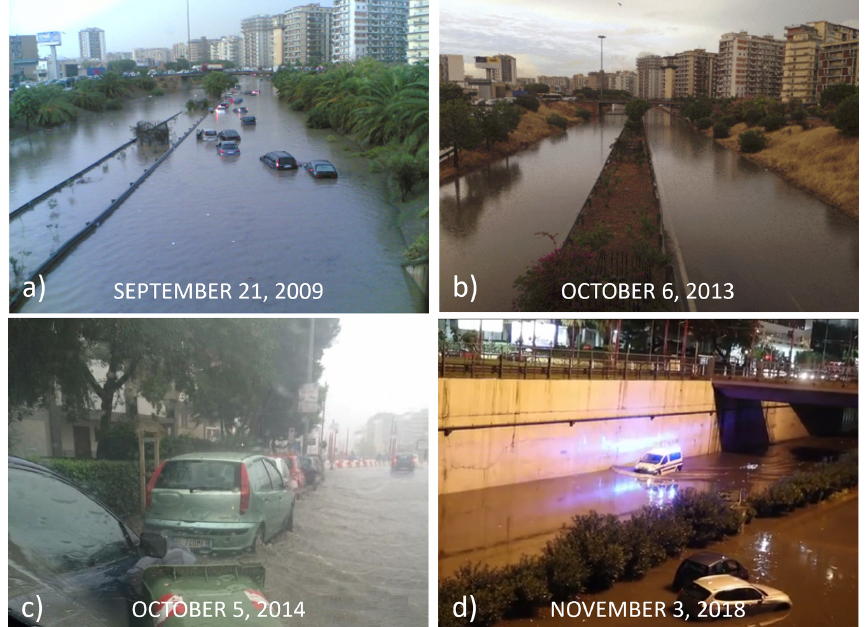
Figure 4. Flooding events that affected the Uditore–Passo di Rigano district on (a) 21 September 2009, (b) 6 Oc- tober 2013, (c) 5 October 2014, and (d) 3 November 2018. Source (a) : Rosalio (https://www.rosalio.it/2009/09/22/ allagamenti-in-citta/, last access: 23 August 2021). Source (b) : La Voce dell’Isola (https://www.lavocedellisola.it/2013/10/